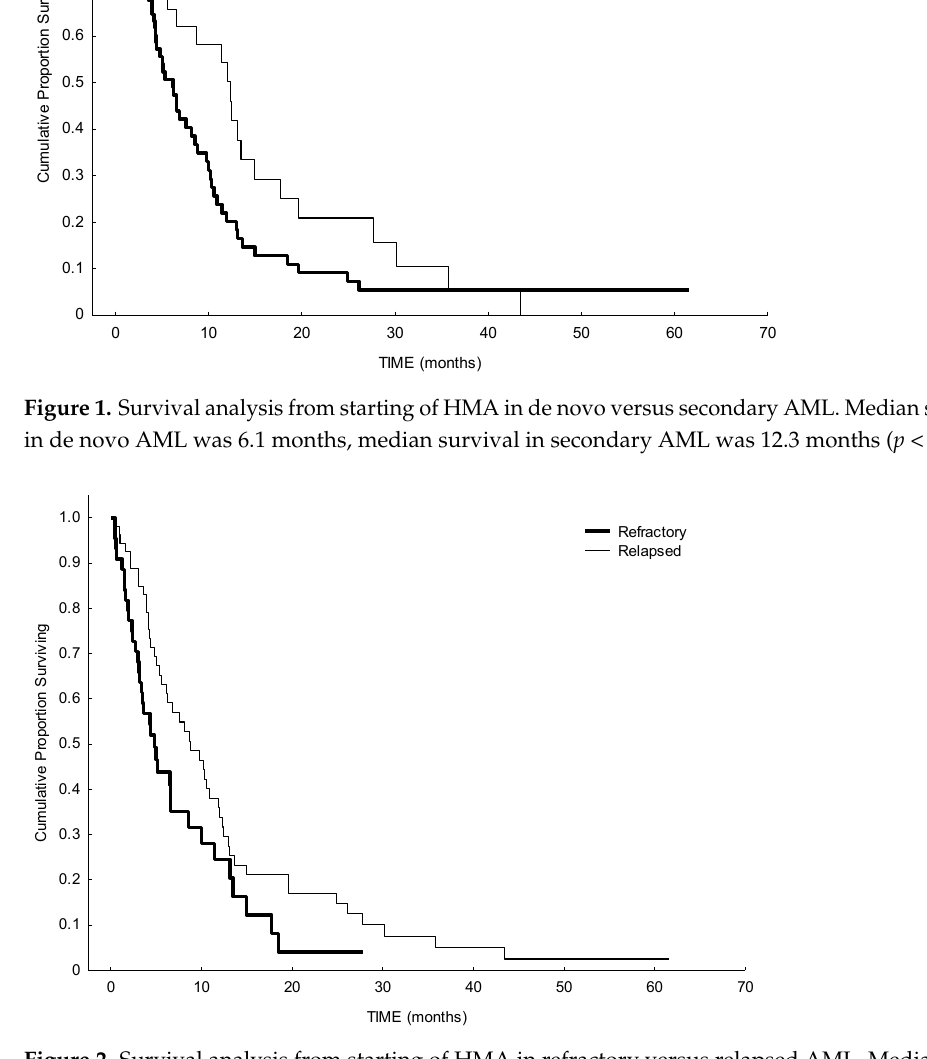
Figure 3. Survival analysis from starting of HMA according to ECOG performance status at relapse. Patients with ECOG 0 showed a median OS of 19.6 months, patients with ECOG 1–2 or 3–4, showed a median OS of 6.5 months and 2.1 months, respectively ( p < 0.0001). Median OS after HMA in patients with SD as best response to HMA was similar to median OS in patients who obtained a response to HMA (10.6 months vs. 13 months), while OS in unresponsive patients was 3.3 months ( p < 0.00001). On multivariate analysis, OS differences between: 1) secondary AML and de novo AML; 2) SD and responsive group vs. progressive disease group; and 3) patients with ECOG 0 and >1 remained sig- nificant. Hazard ratio for death for secondary AML vs. de novo AML was 1.84 (CI 95%, p = 0.018); for ECOG 1–2 patients vs. ECOG 0 patients it was 3.1; and for ECOG 0 vs. ECOG 3–4 it was 6.2, ( p < 0.001, CI 95%).